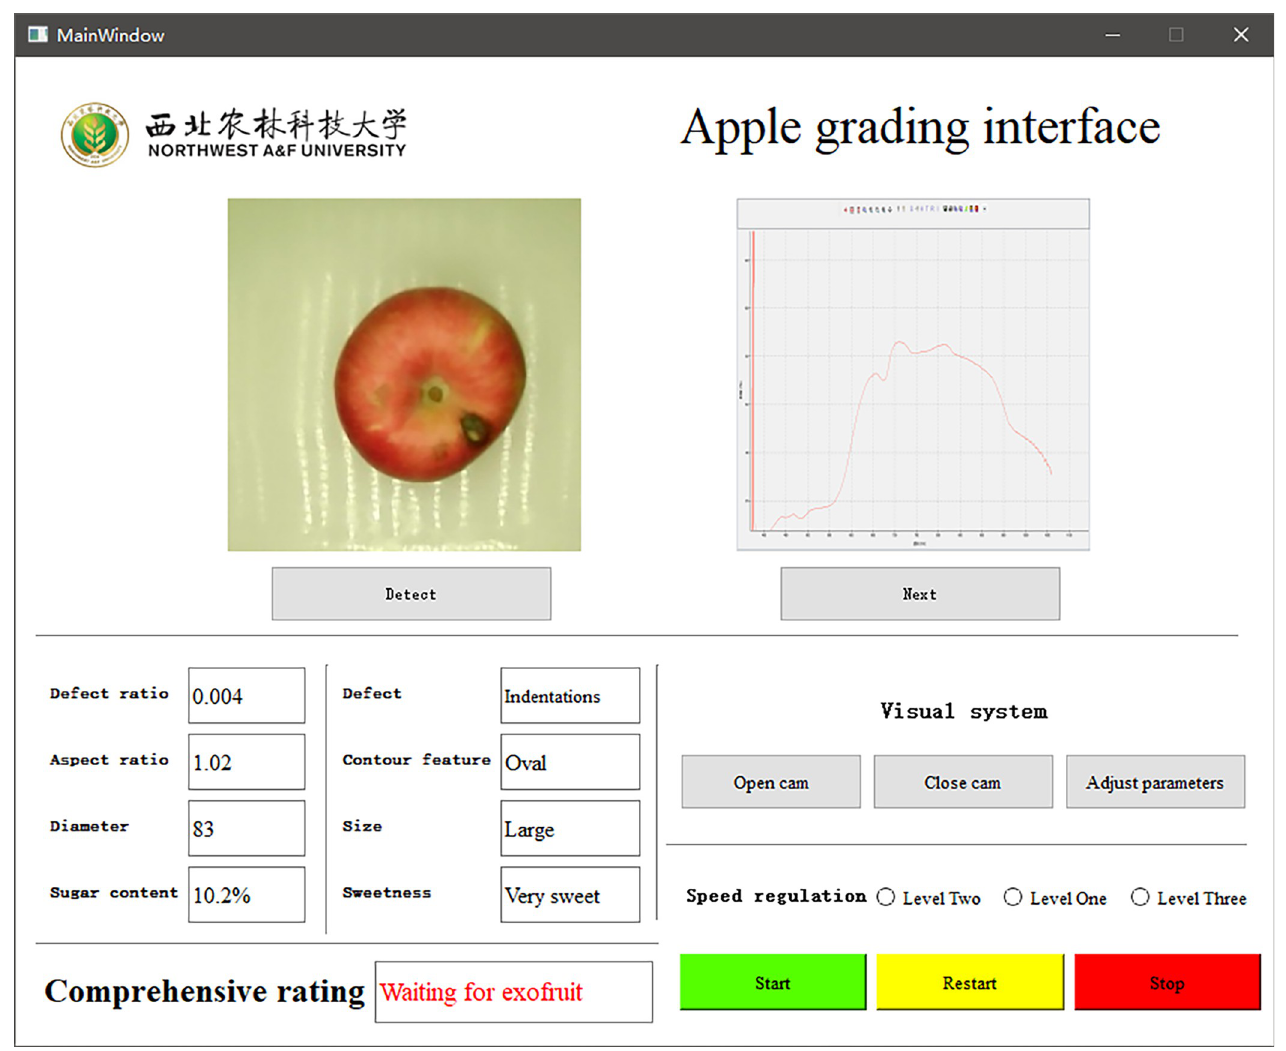
Fig 17. The interface of the apple quality grading software.